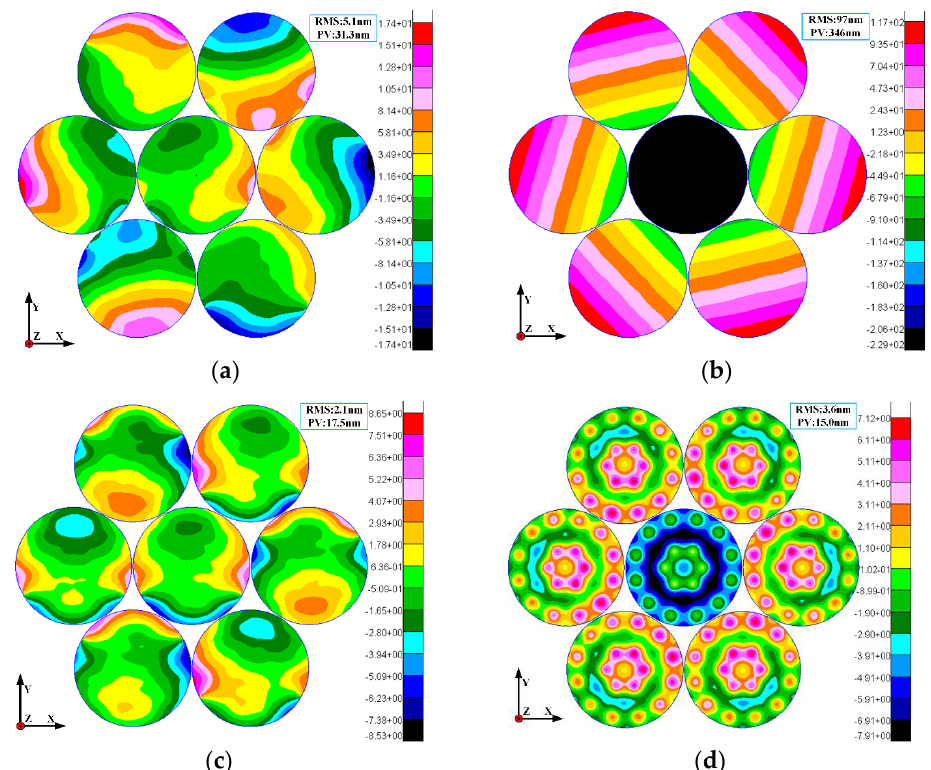
Figure 8. The mirror deformation cloud of the SiC segment after correction by the two schemes, ( a ) Scheme 1, deformation of mirror surface in Y condition, ( b ) Scheme 1, deformation of mirror surface in Z condition, ( c ) Scheme 2, deformation of mirror surface in Y condition, ( d ) Scheme 2, deformation of mirror surface in Z condition.